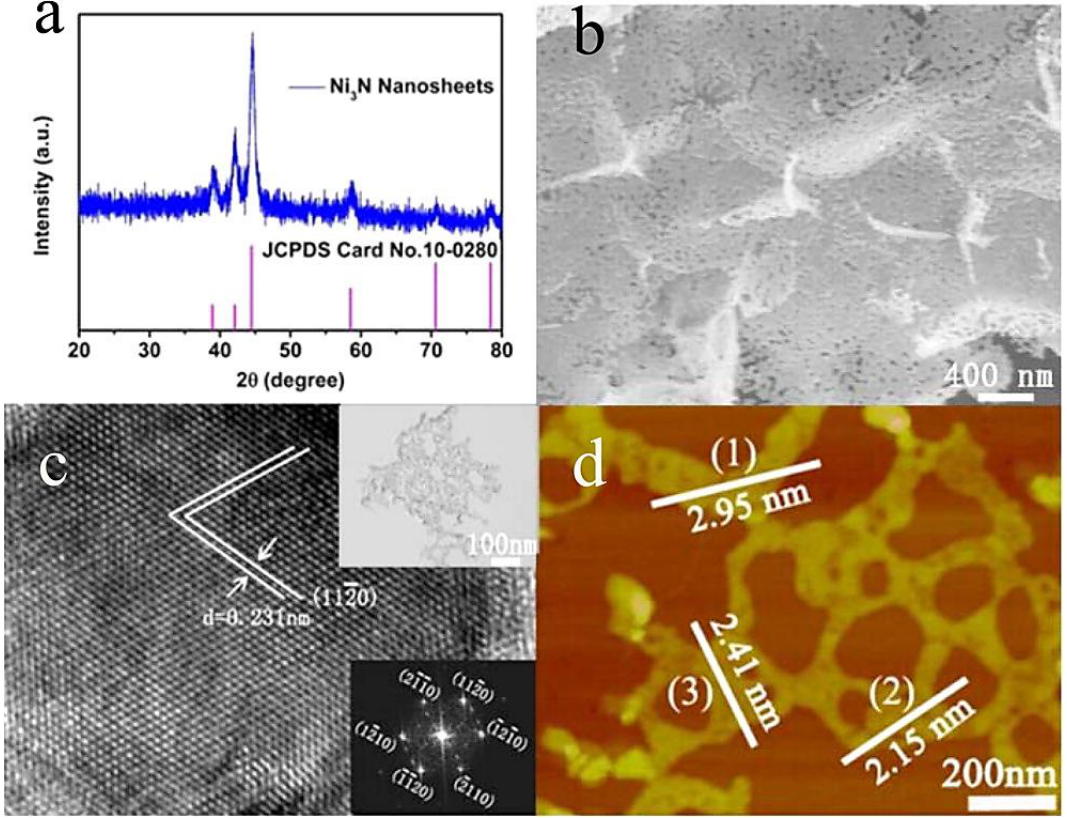
Figure 3. Characterization of Ni 3 N nanosheets. ( a ) XRD pattern; ( b ) SEM image; ( c ) HRTEM image. Inset: corresponding FFT pattern and TEM image; ( d ) AFM image. Reprinted with permission from [85], American Chemical Society, 2015.